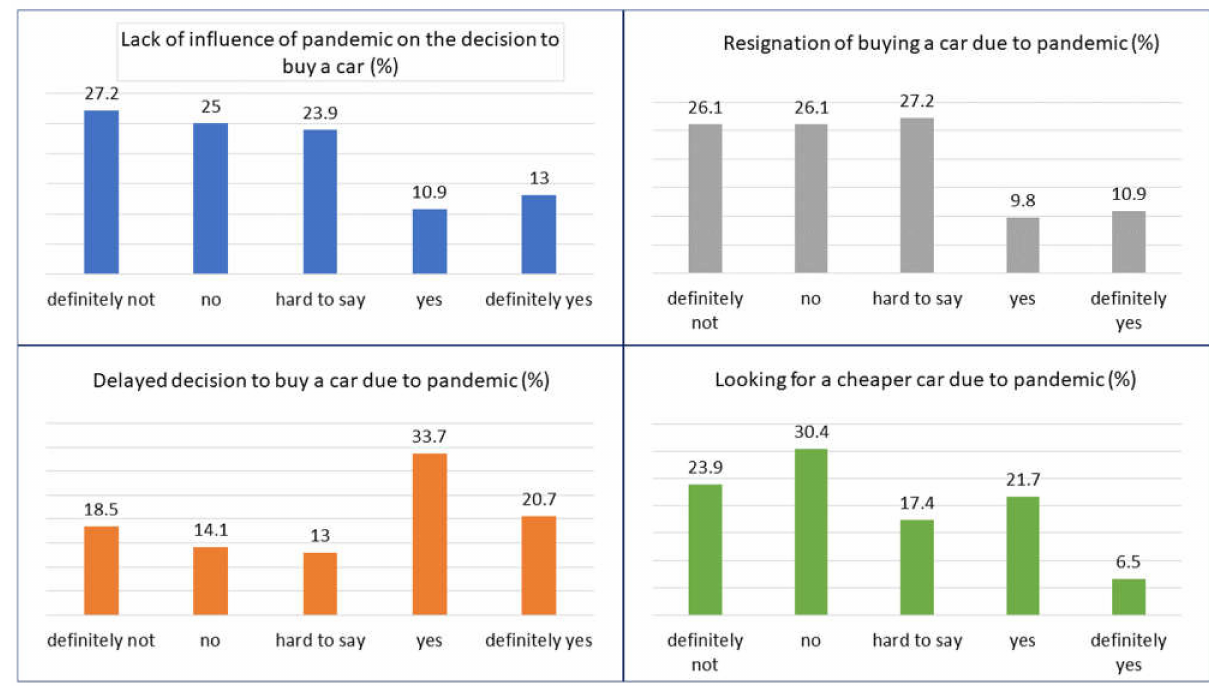
Figure 10. The impact of the COVID-19 pandemic on the decisions of micro-entrepreneurs to buy a car (N =